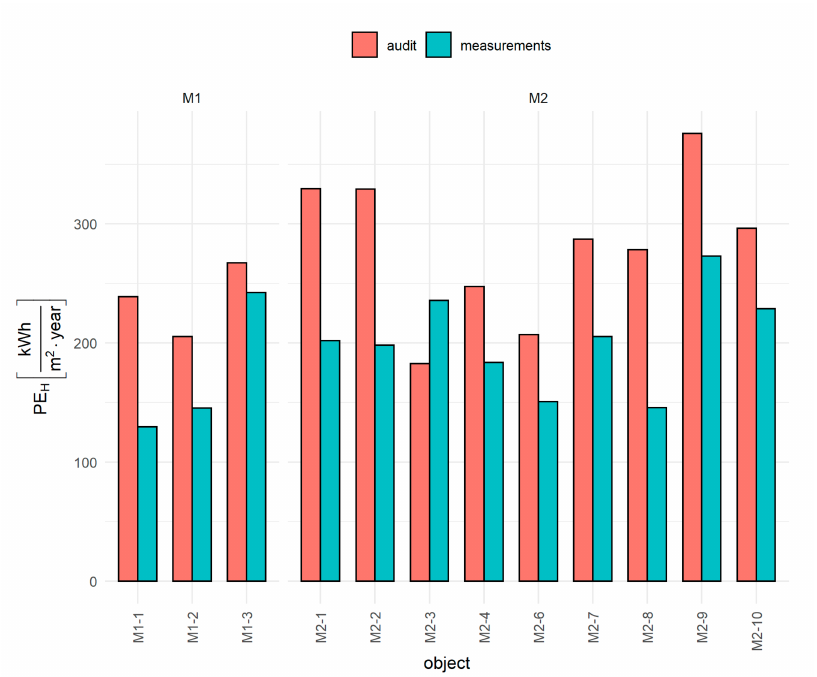
Figure 4. PE H values obtained from measurements and calculated in the audit before thermal refurbishment.